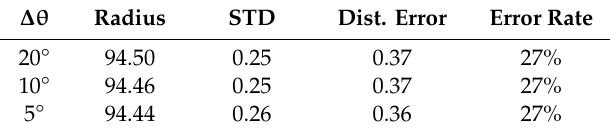
Table 5. Experimental results were obtained at 770 lux Table 4. Experimental results were obtained at 480 lux (mm). Table 4. Experimental results were obtained at 480 lux (mm).